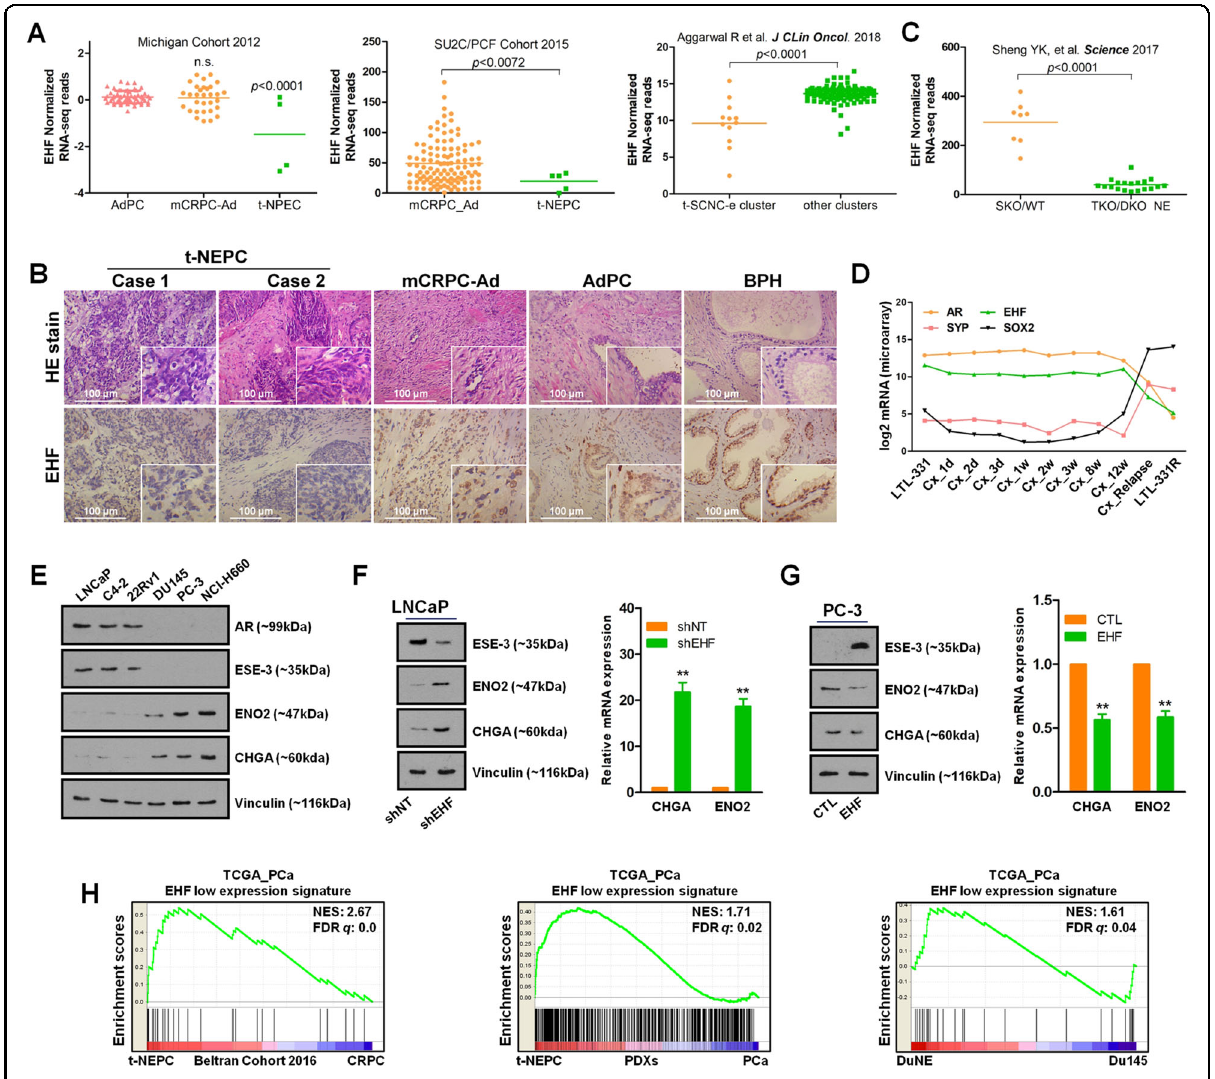
Fig. 1 EHF expression is downregulated in t-NEPC. A EHF mRNA expression of tumor tissues derived from Michigan 2012 25 , SU2C/PCF 2015 26 , and Aggarwal et al. 8 clinical prostate cancer cohorts was plotted. B EHF expression in tumor or prostate tissues from t-NEPC, CRPC-Ad, AdPC, and BPH patients was measured by immunohistochemistry. Scale bar 100 μ m. C EHF mRNA expression from the GEMM models 11 was plotted. D EHF, AR, SYP, and SOX2 mRNA expressions during the progression of AdPC (LTL-331) to t-NEPC (LTL-331R) by castration surgery to the host mice 23 were plotted. E AR, EHF, ENO2, and CHGA protein expressions in LNCaP, C4-2, 22Rv1, DU145, PC-3, and NCI-H660 cell lines were measured by immunoblotting. F ENO2 and CHGA levels in LNCaP cells with/without EHF knockdown were measured by qPCR and immunoblotting. G ENO2 and CHGA levels in PC- 3 cells with/without EHF overexpression were measured by qPCR and immunoblotting. H GSEA revealed the enrichment of the “ EHF low expression- speci fi c genes ” signature into the transcriptome of t-NEPC tumors 7 , t-NEPC PDXs 23 , and NEPC DuNE cell line 12 in comparison with their prostate adenocarcinoma counterparts. All qPCR and immunoblotting assays were repeated in triplicate. The two-tailed Student ’ s t test or one-way ANOVA, followed by Dunnett ’ s t test was used to compare results between two groups with ** denoting p < 0.01. Bar graphs show means ± SD. AdPC localized prostate adenocarcinoma tumors, mCRPC metastatic castration-resistant prostate cancer, Ad adenocarcinoma, t-NEPC treatment-induced neuroendocrine prostate cancer, t-SCNC-e treatment-induced small cell neuroendocrine cancer-enriched, PCa prostate cancer, BPH benign prostate hyperplasia, TCGA The Cancer Genome Atlas, HE hematein – eosin, SKO/WT wild-type and single Pten loss, TKO/DKO Pten plus Trp53 double loss and Pten , Trp53 plus Rb1 loss, NE neuroendocrine, PDXs patient-derived xenografts, n.s. not signi fi